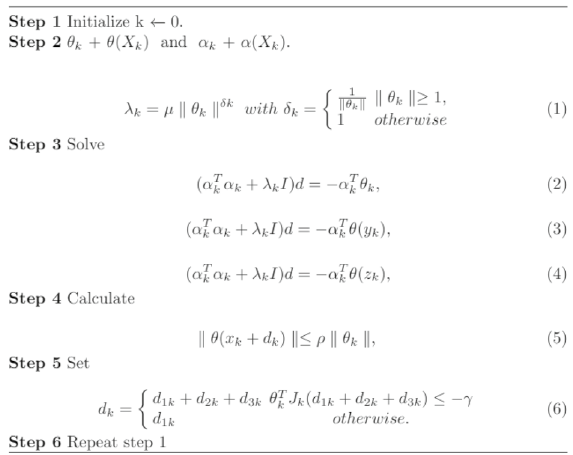
Algorithm 1 Levenberg Marquardt algorithm